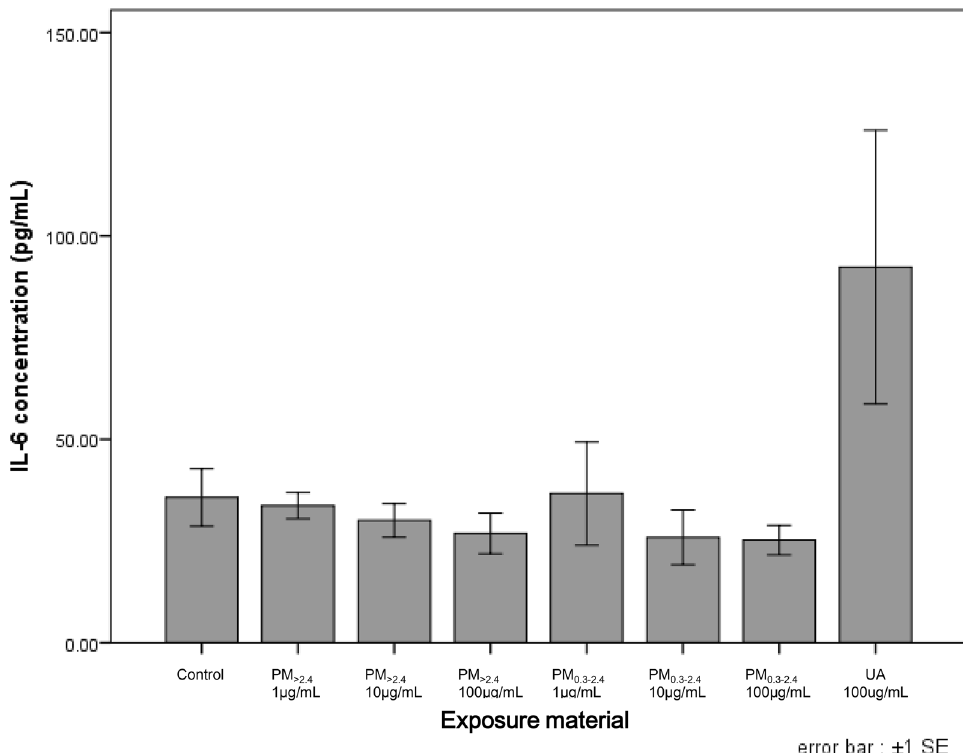
Figure 3. Production of IL-6 from reconstructed human corneal epithelial tissues following exposure to ambient particles and urban aerosols. Each data are mean ± SE of 6 PM >2.4 , 3 PM 0.3–2.4 , 8 UA and 8 control individual cultures. This figure was created using the software SPSS Statistics 24.0 (https ://www.ibm.com/produ cts/spss-stati stics ?lnk=STW_US_STESC H_P1_BLK&lnk2=trial _SPSSs tat&lot=1&pexp=def&psrc=none&mh src =ibmse arch_a&mhq=spss). IL interleukin, SE standard error of the mean, PM > 2.4 particle matter larger than 2.4 µm,